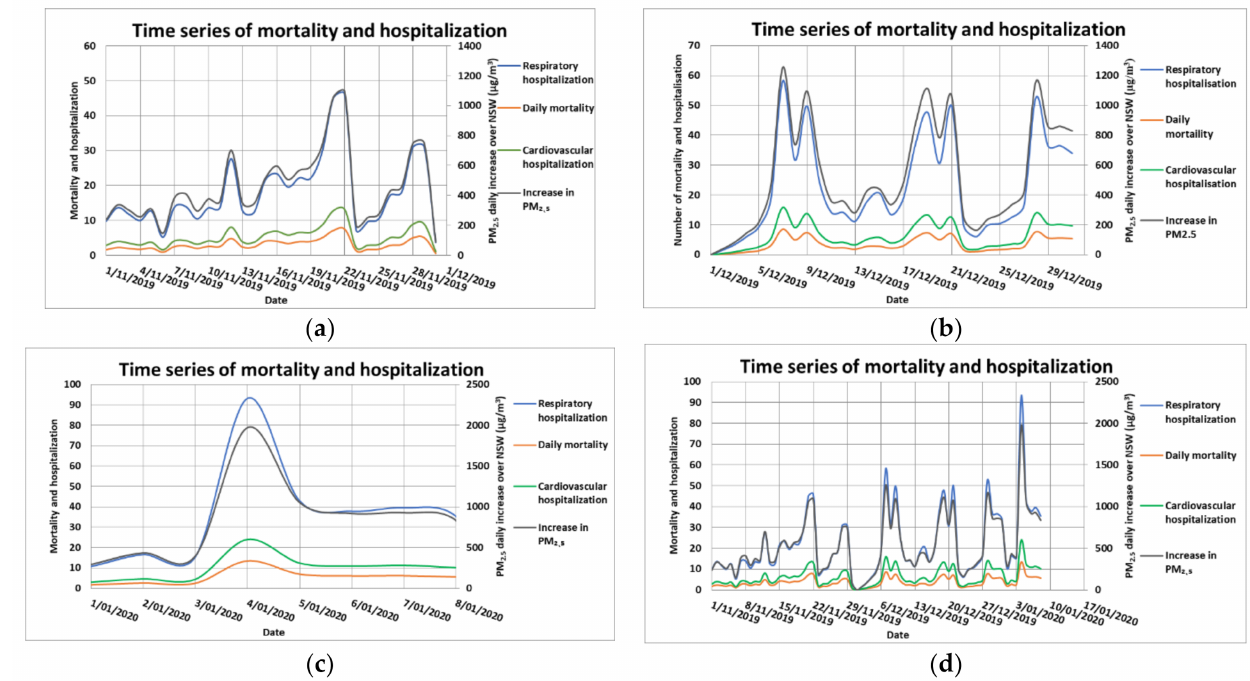
Figure 12. Daily time series of increase in PM 2.5 over all the census districts (SA4s) in NSW and the rates of mortality and hospitalizations (due cardiovascular and respiratory diseases) due to wildfires in November 2019 ( a ), December 2019 ( b